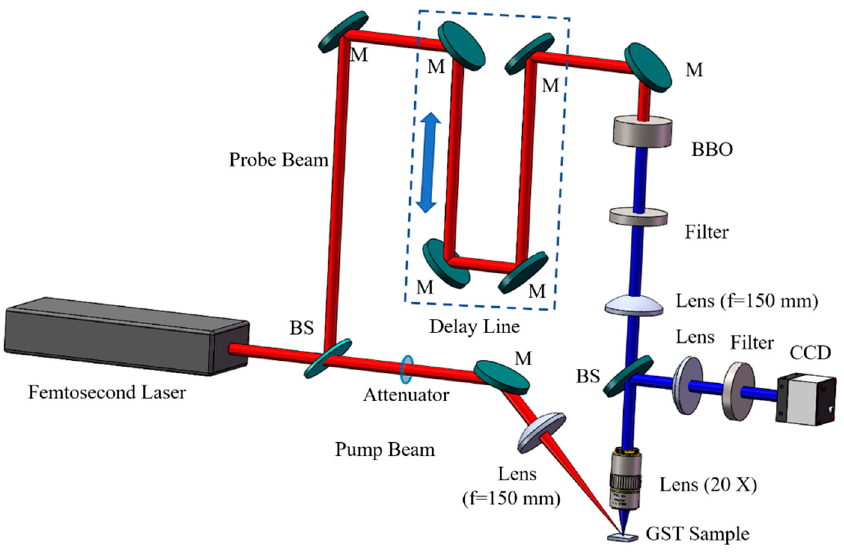
Figure 1. The schematic of the reflective-type pump–probe system (BS: beam splitter, M: mirror).